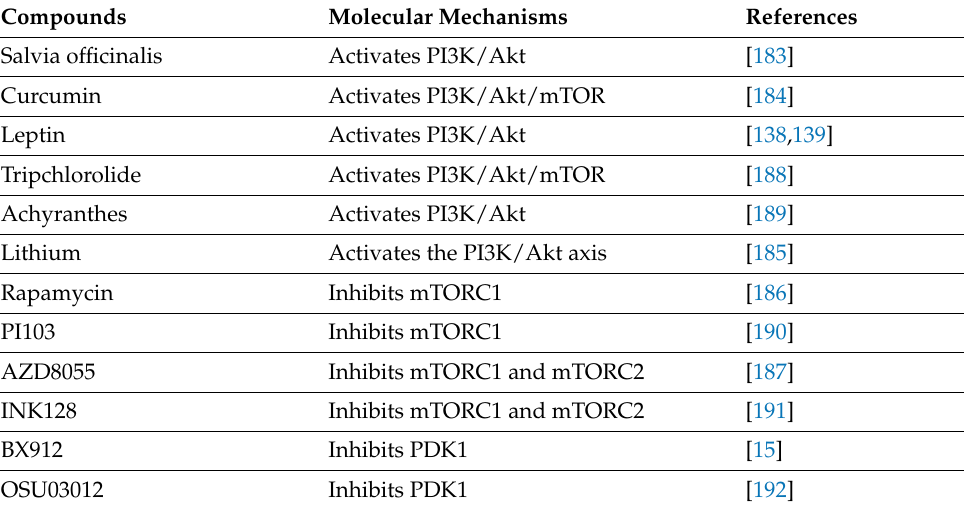
Table 1. List of chemical compounds used for the treatment of AD.